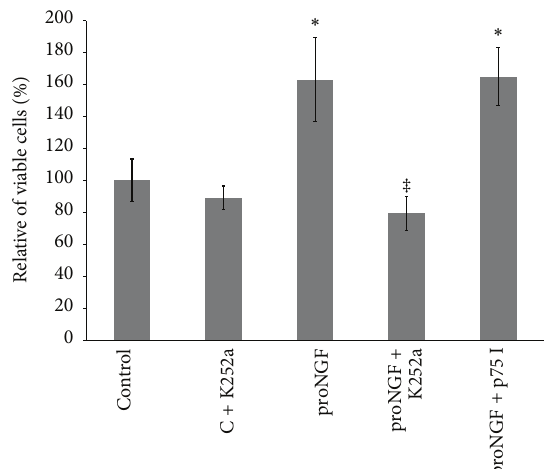
Figure 5: Inhibiting TrkA prevents proNGF-mediated retinal endothelial cell proliferation. BRE cells were grown into confluence and then trypsinized and plated as described in method section. Cells were switched to serum free medium and treated with mutant proNGF (50 ng/mL) in the presence or absence of K252a, TrkA inhibitor (0.1 𝜇 M), or p 75 NTR inhibitor (20 𝜇 M) for 24 hours and then cells were trypsinized and counted. Statistical analysis showed that proNGF increased the percentage of proliferated cells by 1.6- fold compared to the control group. This effect was blocked by the specific TrkA receptor antagonist (K252a) but not with p75 inhibitor ( ∗,‡ statistically significant compared to control and proNGF groups, resp. ( 𝑃 < 0.05 ), 𝑛 = 5 – 7 ).